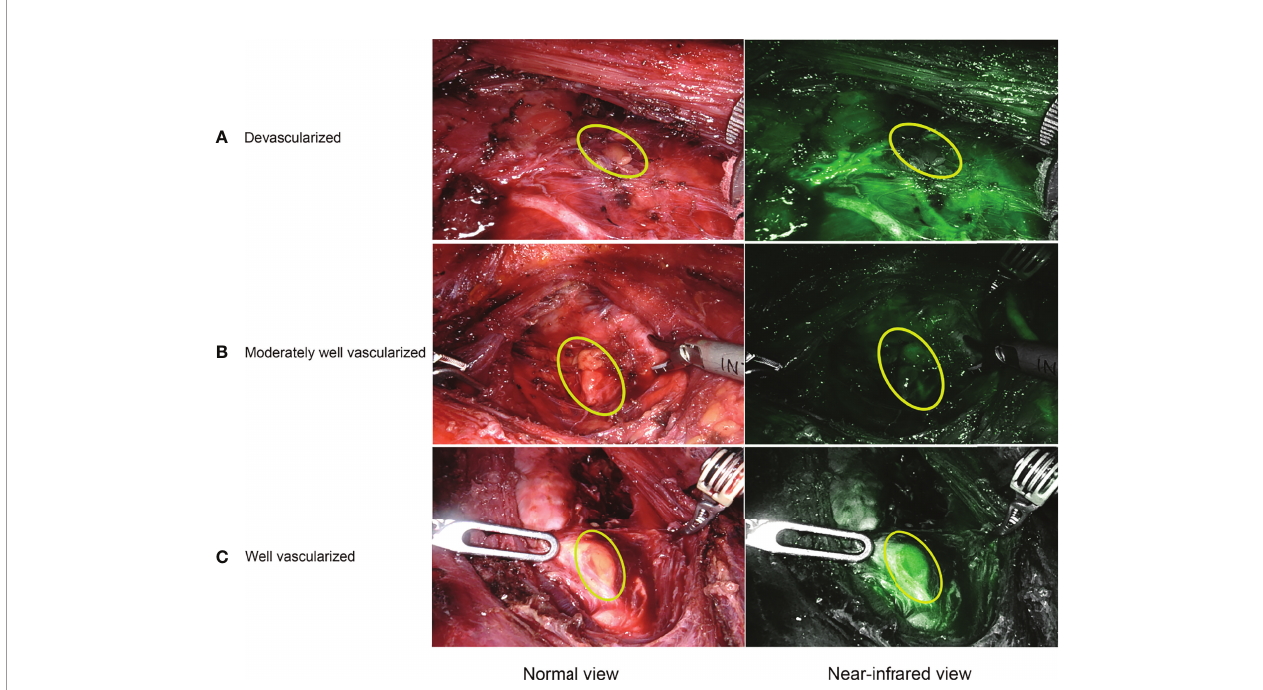
FIGURE 3 | Representative ICGA images. (A) a devascularized parathyroid gland (ICG score 0). (B) a moderately well vascularized parathyroid gland (ICG score 1). (C) a well vascularized parathyroid gland (ICG score